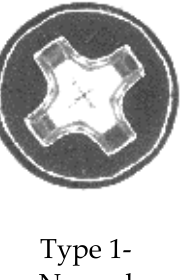
Figure 11. Schematic showing the experimental procedure.